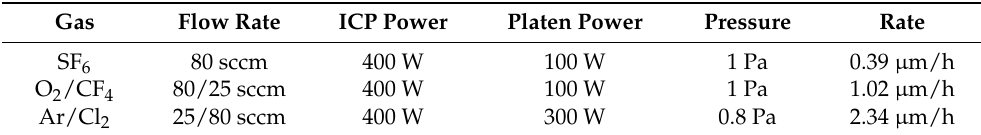
Table 2. Diamond etching removal